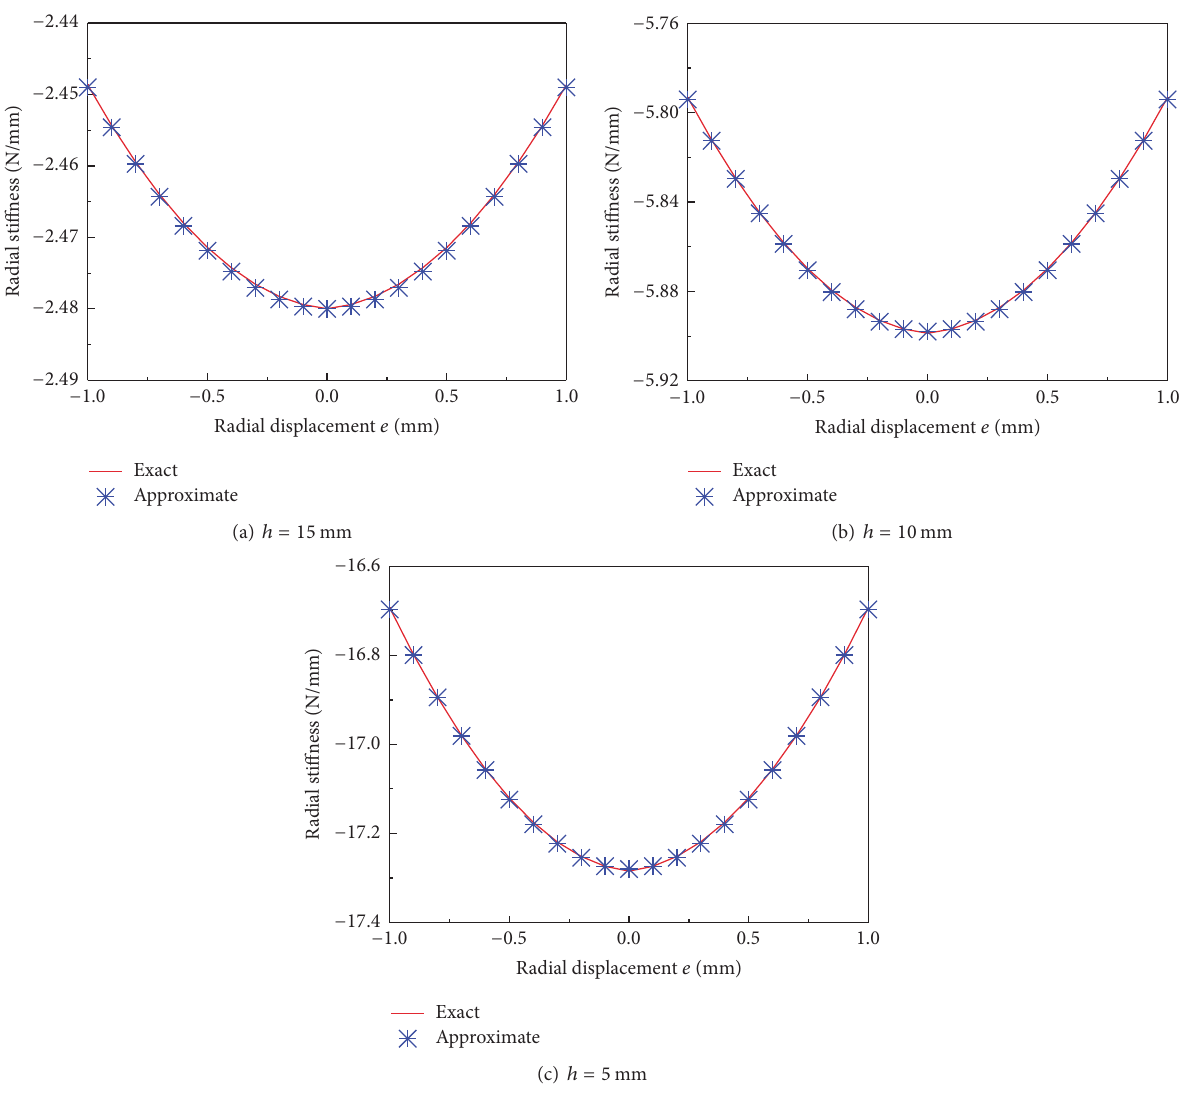
Figure 4: Approximate stiffness and exact stiffness comparison when ℎ is 15 mm, 10mm, and 5 mm, respectively.